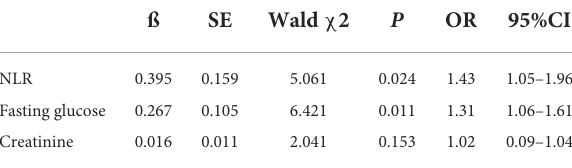
TABLE 2 Results of multiple logistic regression analysis of the possible correlates for